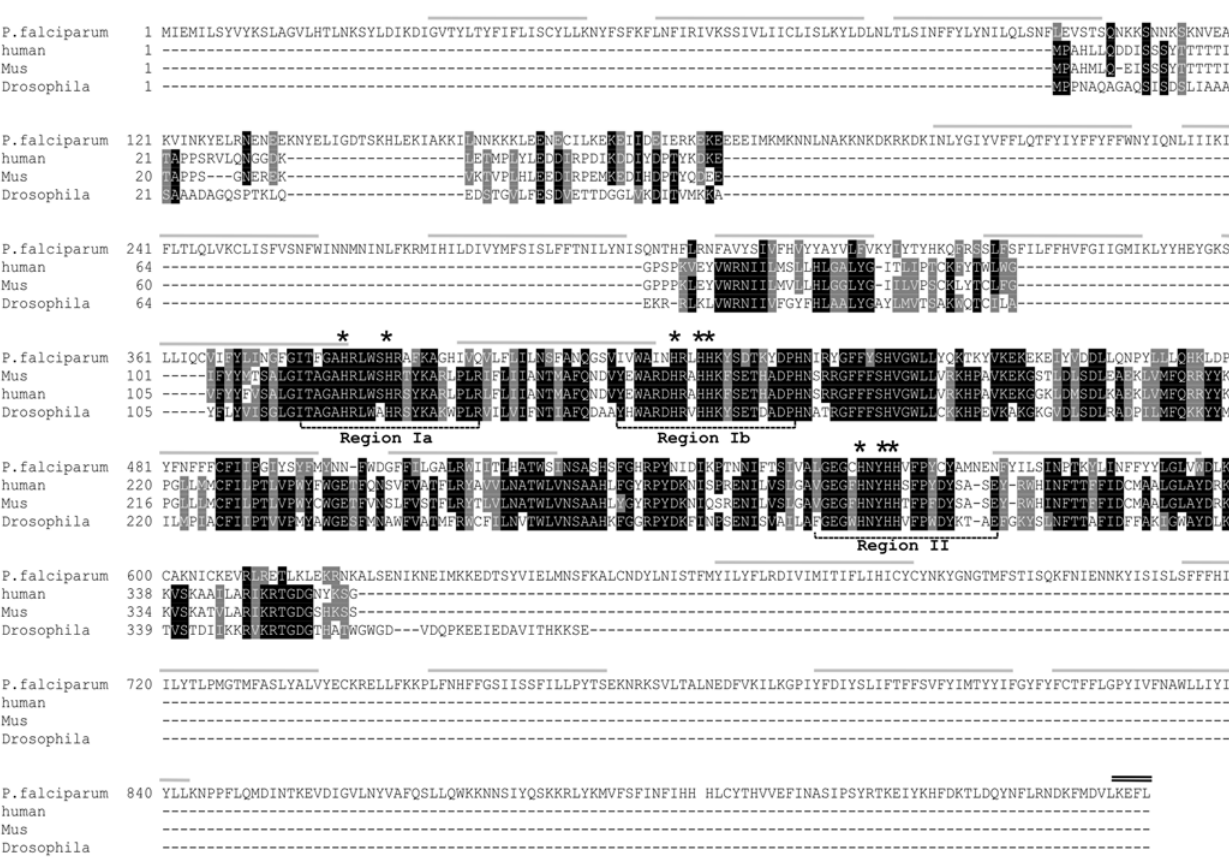
Figure 1. Aligned sequences of stearoyl-CoA D 9-desaturases. Multiple sequence alignment was performed using CLUSTALW (http://www.ebi. ac.uk/Tools/clustalw2/index.html) and the BoxShade package (http://www.ch.embnet.org/software/BOX_form.html). P. falciparum SCD (GenBank accession number Q8I0W9) was compared with human SCD1 (accession number: O60427), Mus musculus SCD1 (accession number Q547C4) and Drosophila melanogaster SCD1 sequence (accession number Q7K4Y0). PfSCD transmembrane domains were predicted using the TMHMM package (http://www.cbs.dtu.dk/services/TMHMM-2.0/) and are shown in grey. Stars indicate the eight conserved His residues (2 in region Ia, 3 in region Ib, and 3 in region II). Identical amino acid residues are in black and homologous residues are shaded in grey. Gaps were introduced to facilitate the sequence alignment. The ER retention KDEL motif is indicated by a double black line.